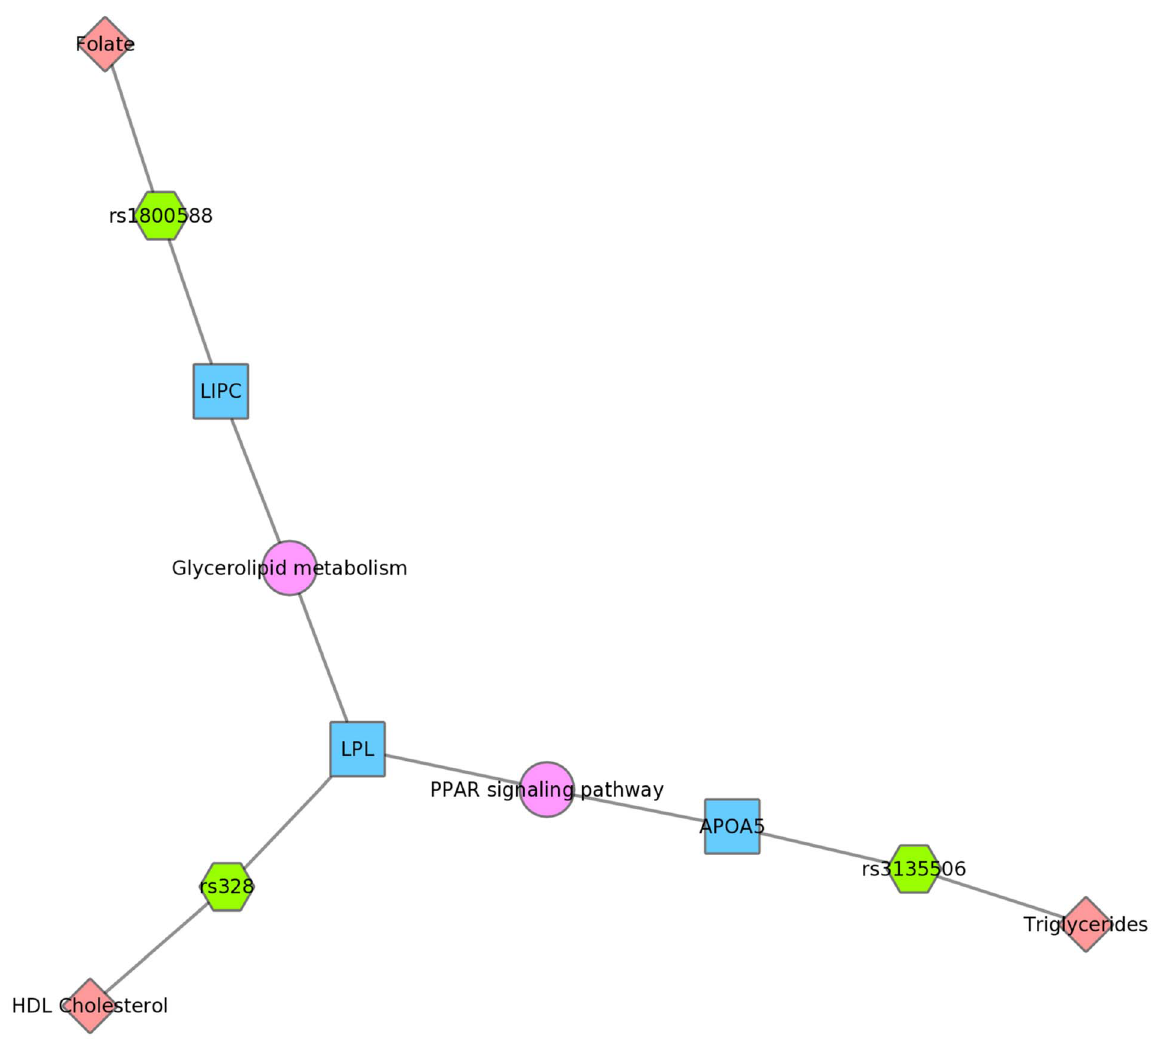
Fig. 10. Using PheWAS results, Biofilter, and Cytoscape to explore gene-gene connections with KEGG connections. The LIPC SNP rs1800588 was associated with folate levels, the LPL SNP rs328 was associated with HDL cholesterol, and both of these genes are in the glycerolipid metabolism KEGG pathway in Mexican Americans. The APOA5 SNP rs135506, associated with triglyceride levels in our study, shares the PPAR signaling pathway along with LPL .